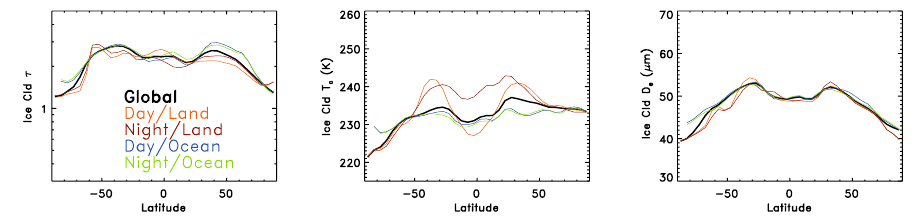
Fig. 12. Zonal averages of τ (left), T C , ICE (center), and D e (right) for 2007. Only retrievals for QC = 0 and 1 are used. Shown are the global results as well as the day vs. night and the land vs. ocean distributions.